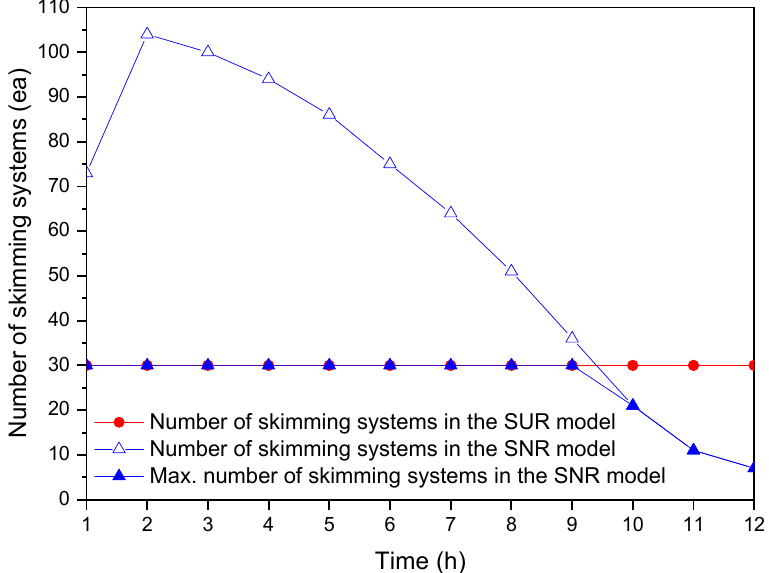
Figure 4. Comparison of skimming systems quantity applied in the calculation and the maximum number of skimming systems, x(t) , with time in the SNR model; effect of considering the space occupied by an individual skimming system and the interactions between multiple skimming systems.